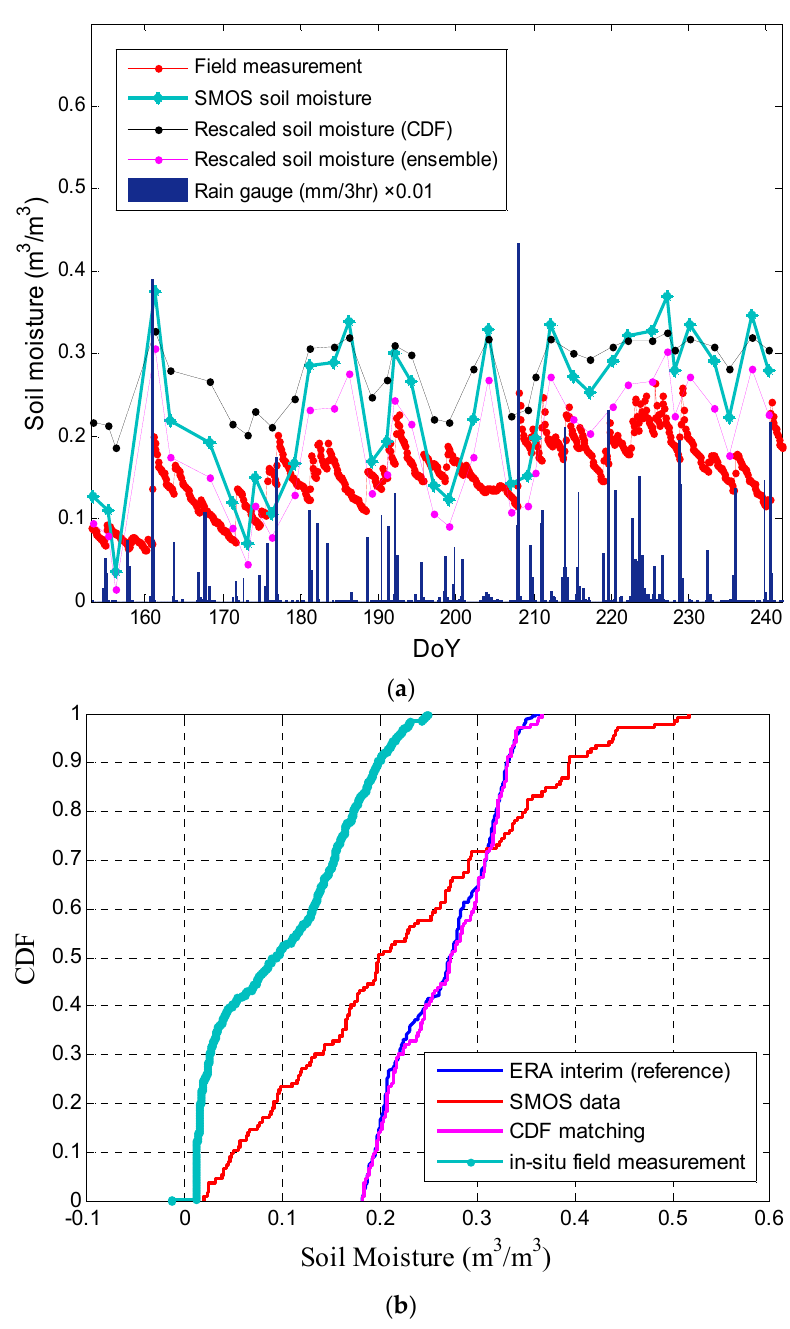
Figure 4. Soil moisture in Benin: ( a ) time-series comparisons; ( b ) cumulative distribution of reference data (ERA interim), SMOS data, CDF matching, and field measurements.